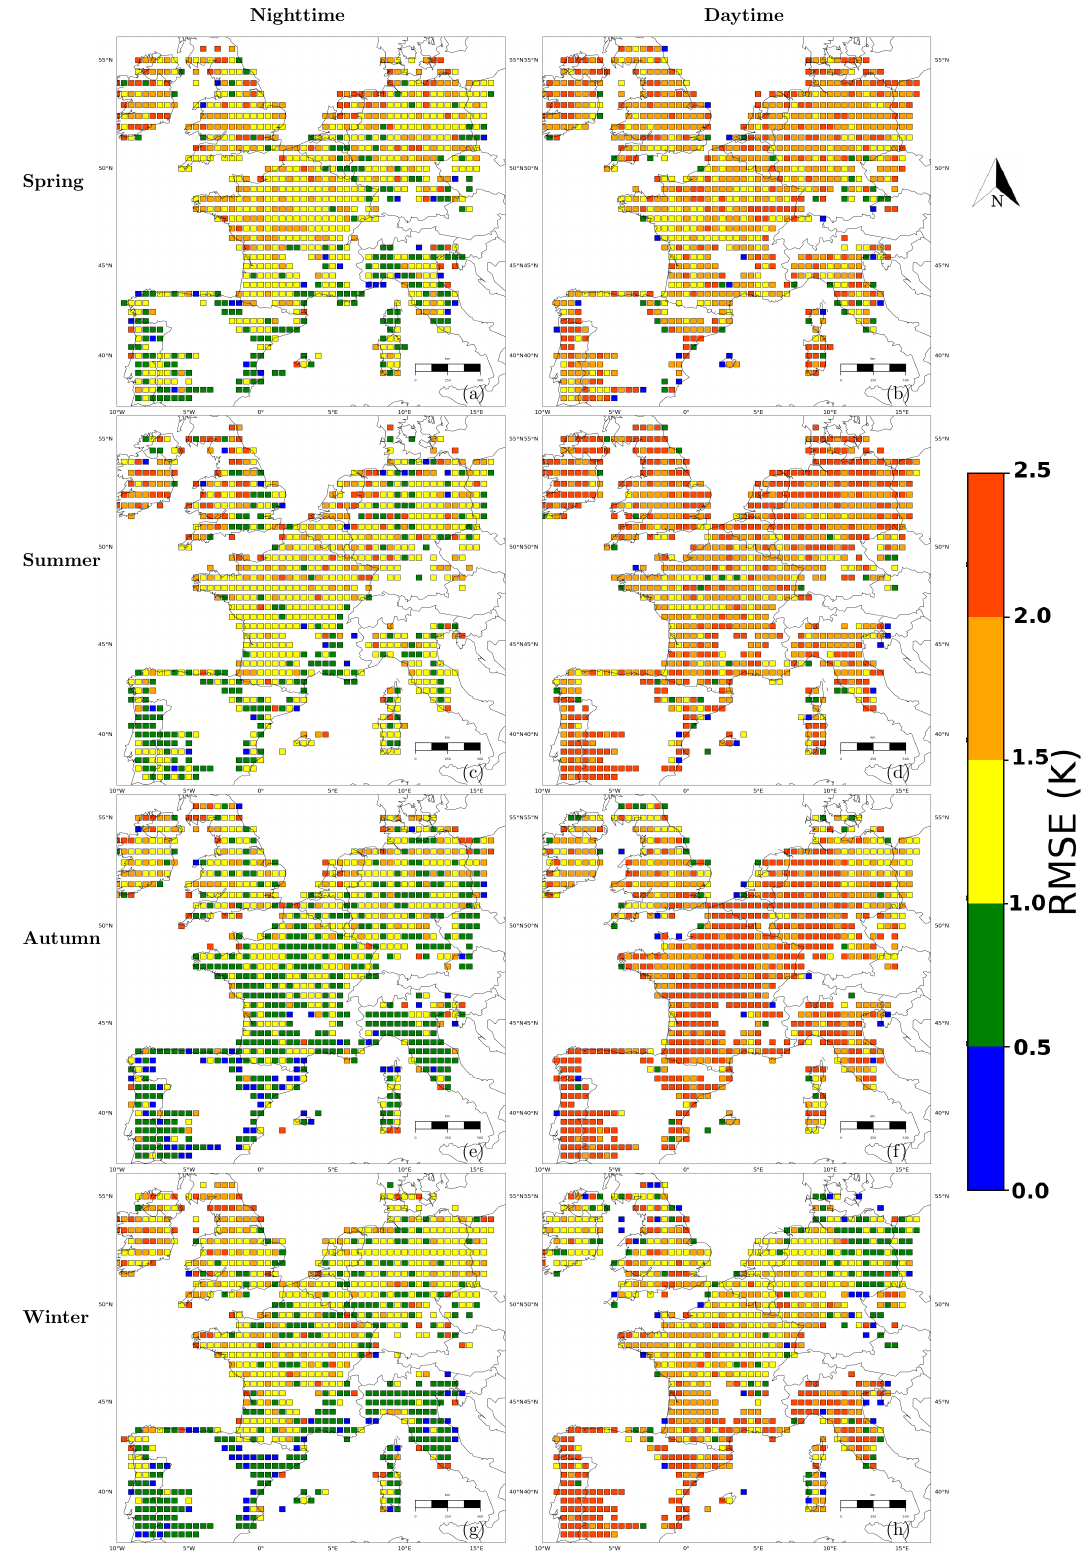
Figure 7. RMSE of difference between IASI and SEVIRI Land Surface Temperature (in K) averaged on a 0.5 ◦ 0.5 ◦ resolution grid for: April/May 2018 by nighttime ( a ) and daytime ( b ); July/August × 2018 by nightime ( c ) and daytime ( d ); October/November 2018 by nighttime ( e ) and daytime ( f ); January/February 2018 by nighttime ( g ) and daytime ( h ). The lack of data in the Iberian peninsula and mountainous areas is mainly due to the orography threshold of 400